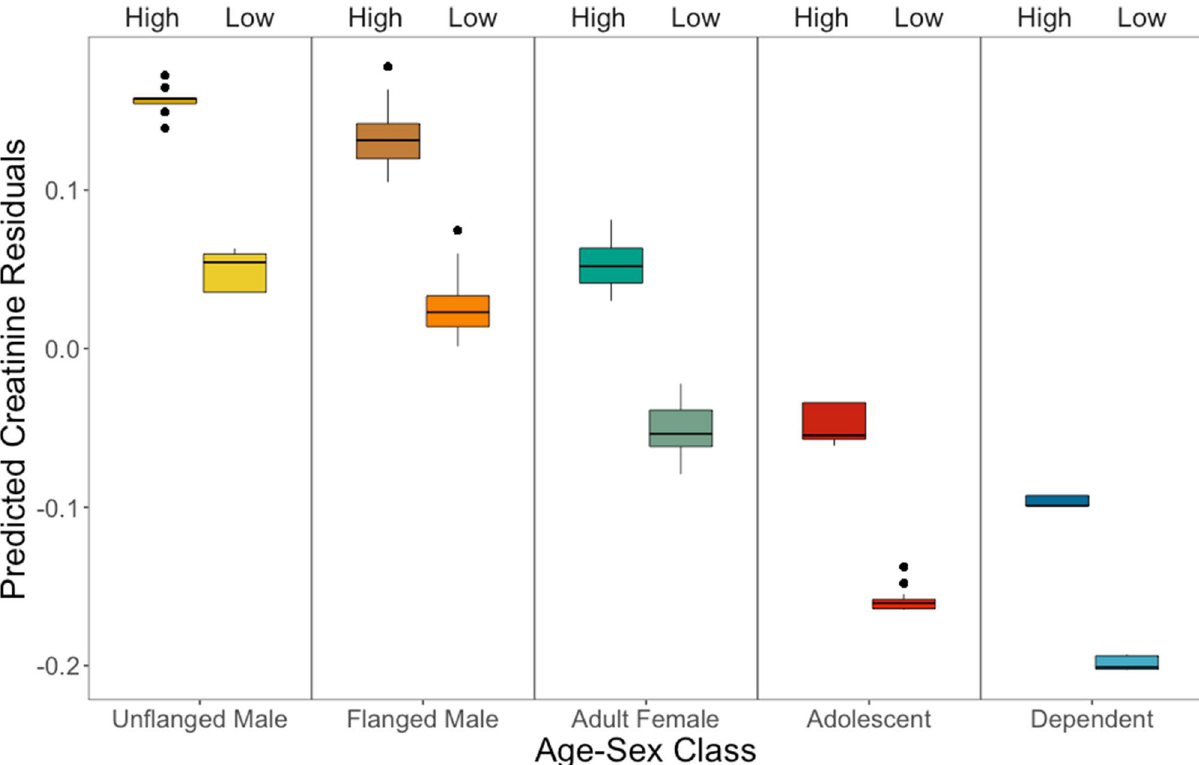
Figure 2. Predicted ELBM of each age-sex class using FAI as a binary predictor (high and low fruit, see S1 for GLMM